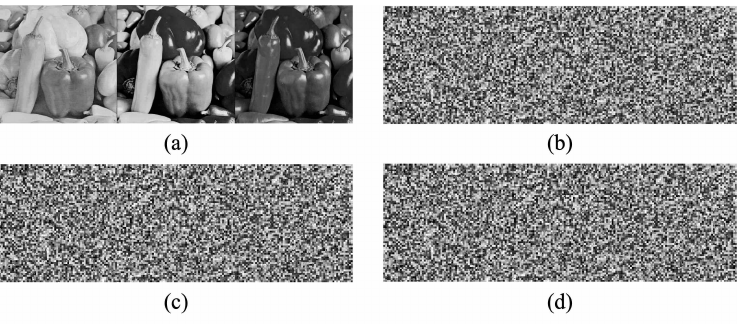
Figure 10. Marked encrypted images (peppar). ( a ) Grayscale-based image; ( b ) L = 1, ( c ) L = 3; ( d ) L = 10.